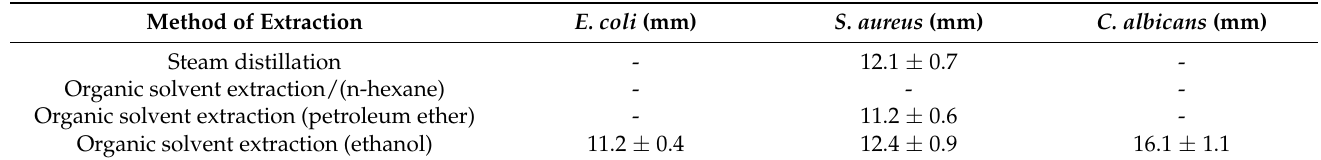
that the SPEO concentration was linearly correlated with the peak area.